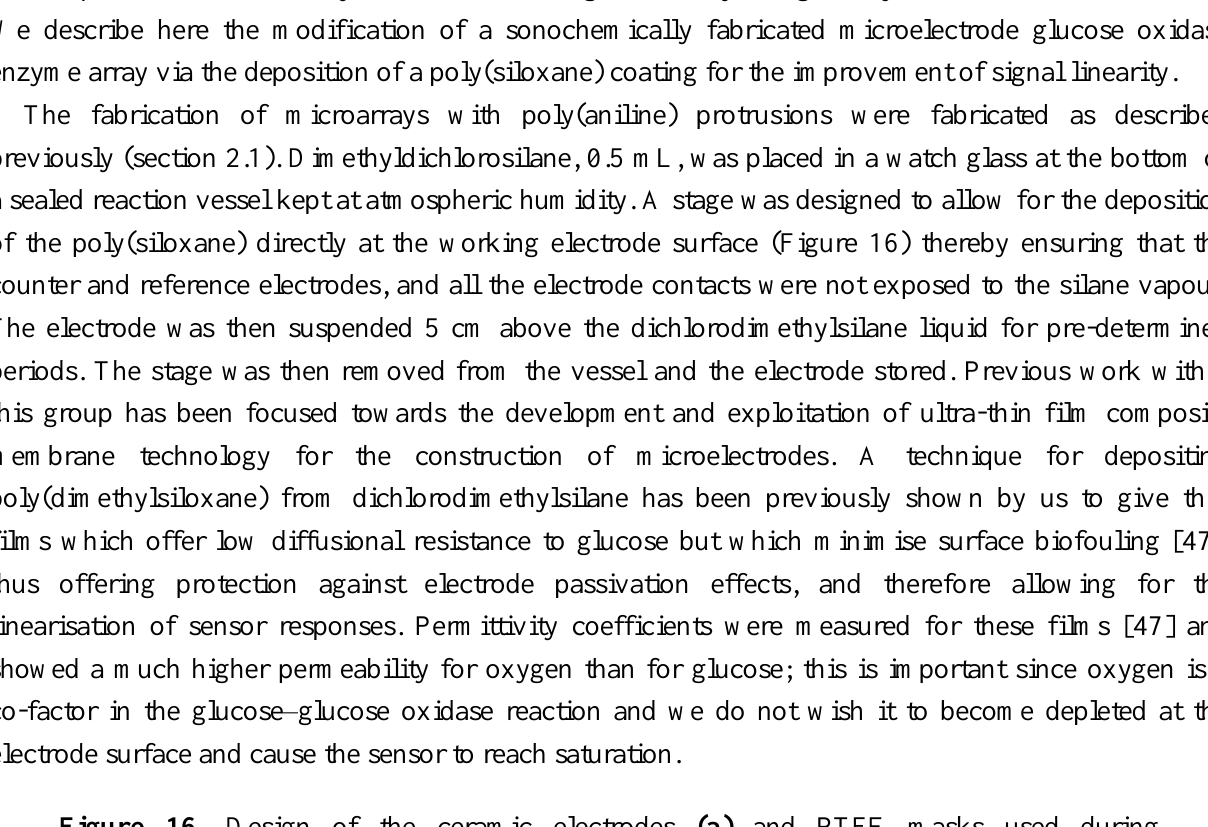
Figure 16. Design of the ceramic electrodes (a) and PTFE masks used during poly(siloxane) deposition (b)